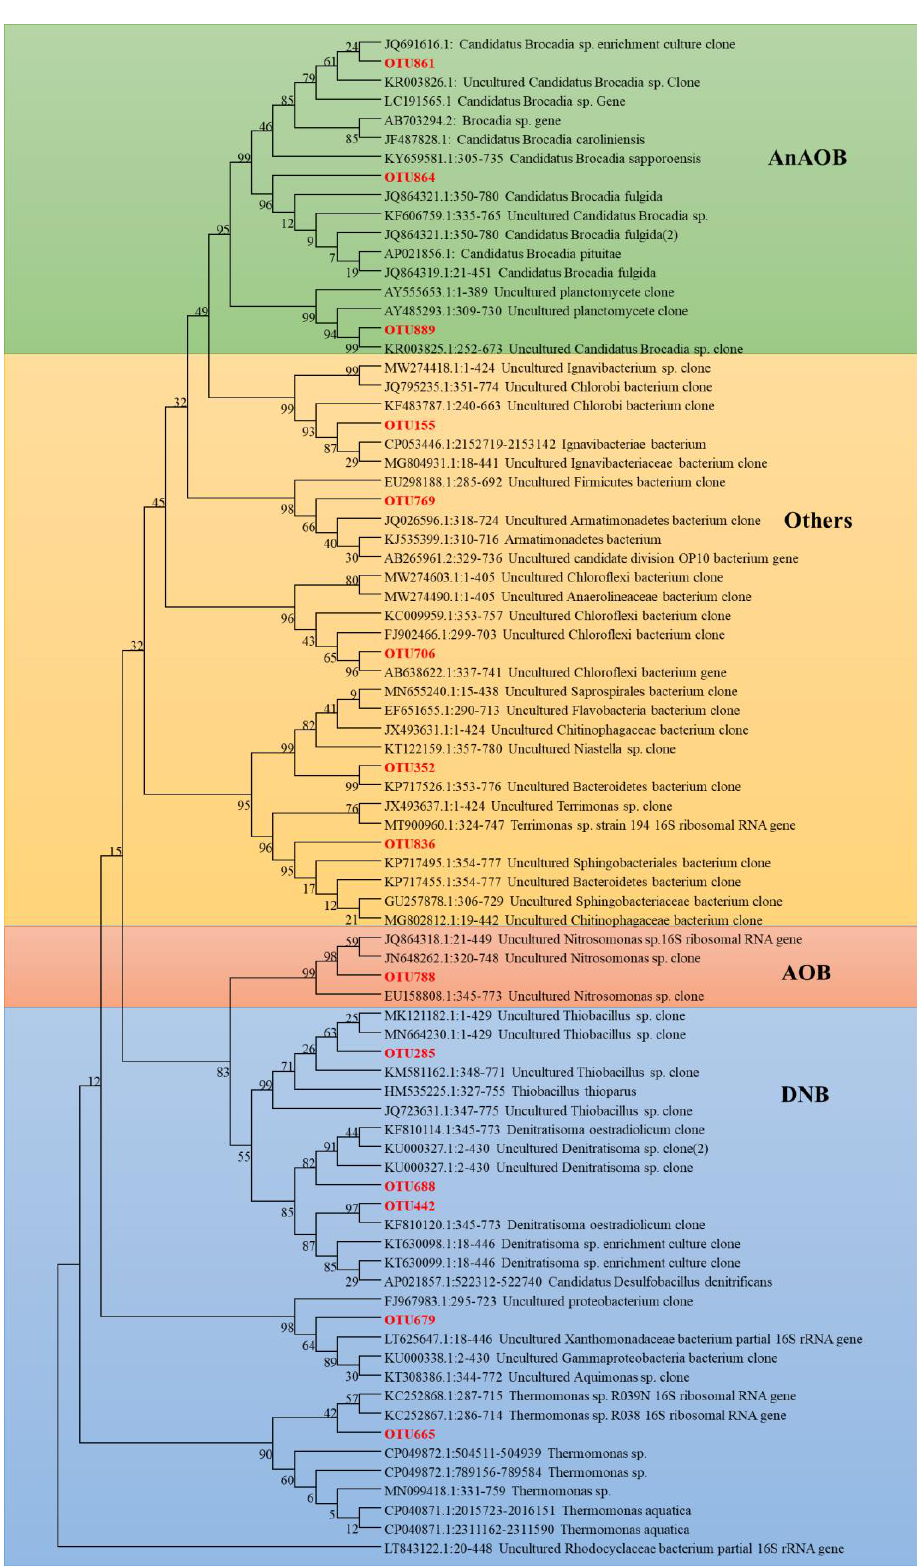
Figure 5. Phylogenetic tree of 14 dominant 16S rDNA partial sequences recovered from the MBBR reactor. 16S rDNA partial sequences recovered from this study are shown in red and closely related genes downloaded from the NCBI are shown in black. GenBank accession numbers of genes down- loaded from the NCBI were presented at the beginning of these genes. Bootstrap support values are represented at branch